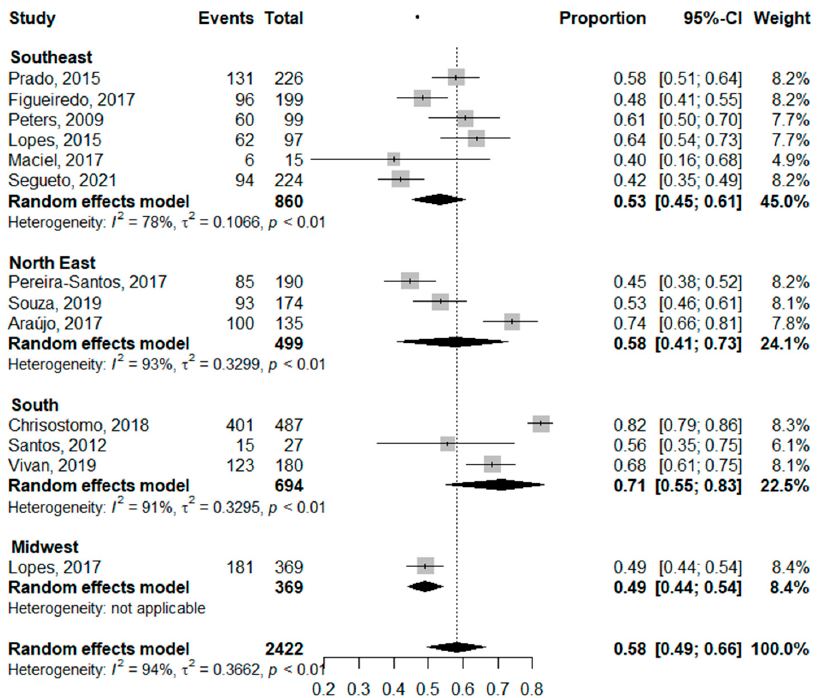
Figure 5. Prevalence of Vitamin D insufficiency in childbearing women stratified by Brazilian geographic region. [33–36,39–41,43,44,46–48]. A slight asymmetry to the left is observed in the funnel plot for vitamin D deficiency in women of childbearing age, indicating a heterogeneity between studies (Figure 6). The funnel plot for vitamin D insufficiency in women of childbearing age did not show asymmetry, indicating less heterogeneity than the vitamin D deficiency plot (Figure 7).